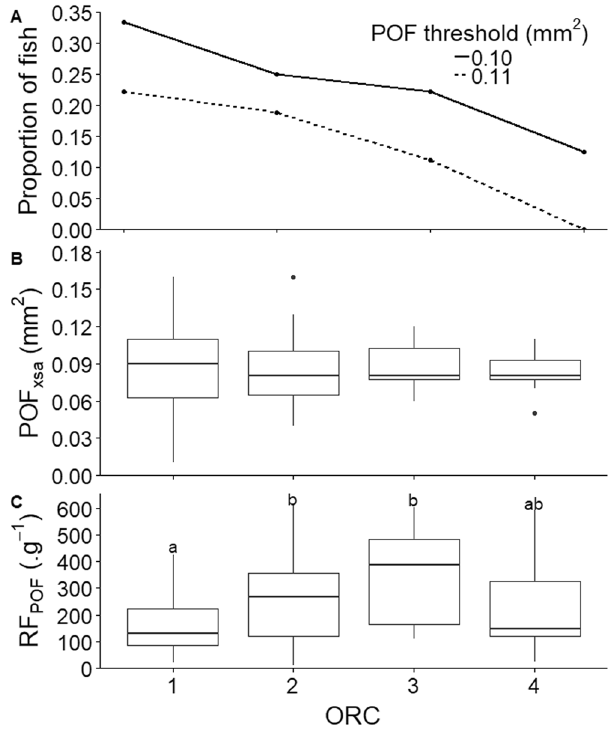
Figure 6. POF metrics (presence, size and fecundity) as a function of ORC. In each ORC: ( A ) The proportion of fish that had a POF larger than a given size threshold (POF XSA > 0.10 or > 0.11 mm 2 ). This measure can be used as a proxy for the presence of very recent spawners. ( B ) Median post-ovulatory follicle area (POF XSA ), based on the largest POF from each female, and ( C ) median relative number of post-ovulatory follicles (RF POF ), when taking all POFs into account. Different superscripts denote statistical significance. Boxplots are in the style of Tukey (median = 50% quantile; upper and lower hinges = 75 and 25% quantile, respectively; whiskers, e.g. upper whisker = largest observation less than or equal to upper hinge + 1.5 × interquartile